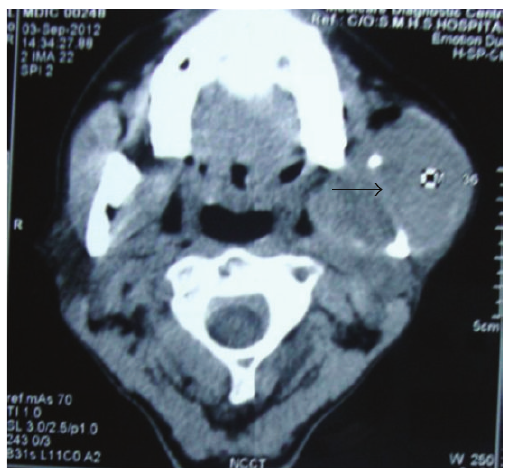
Figure3:CTparotidregiondepictingosteolyticlesioninramusand posterior body of mandible on left side.